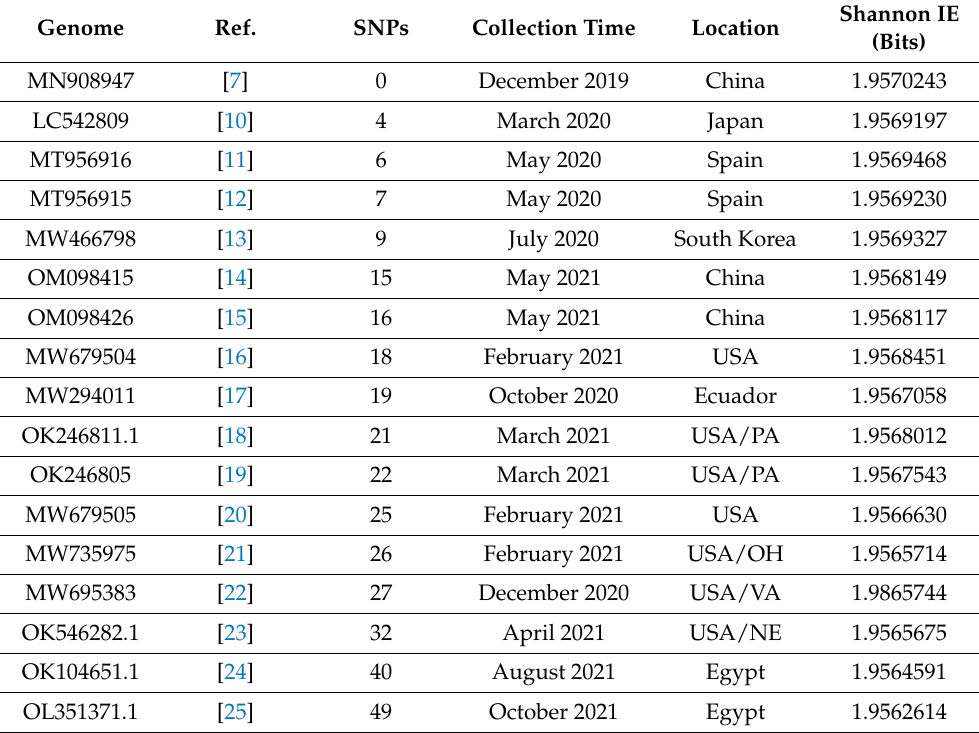
Table 1. Tabulated results of the analysis performed on selected SARS-CoV-2 variants sequenced at various locations around the globe, over a period of 22 months. Genome